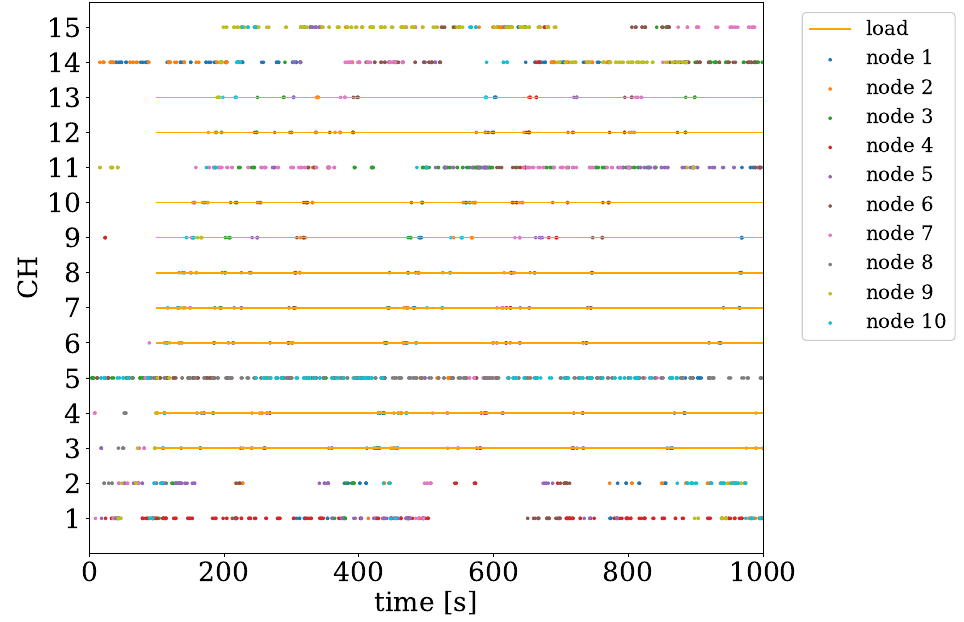
Figure 6. Example of channel selection based on TOW method in the heterogeneous IoT